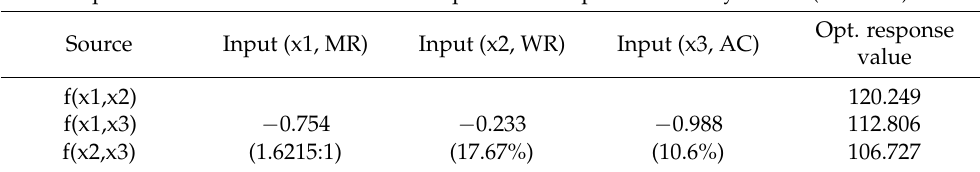
0.5722x2x3 − 12.56x3 2 Opt.